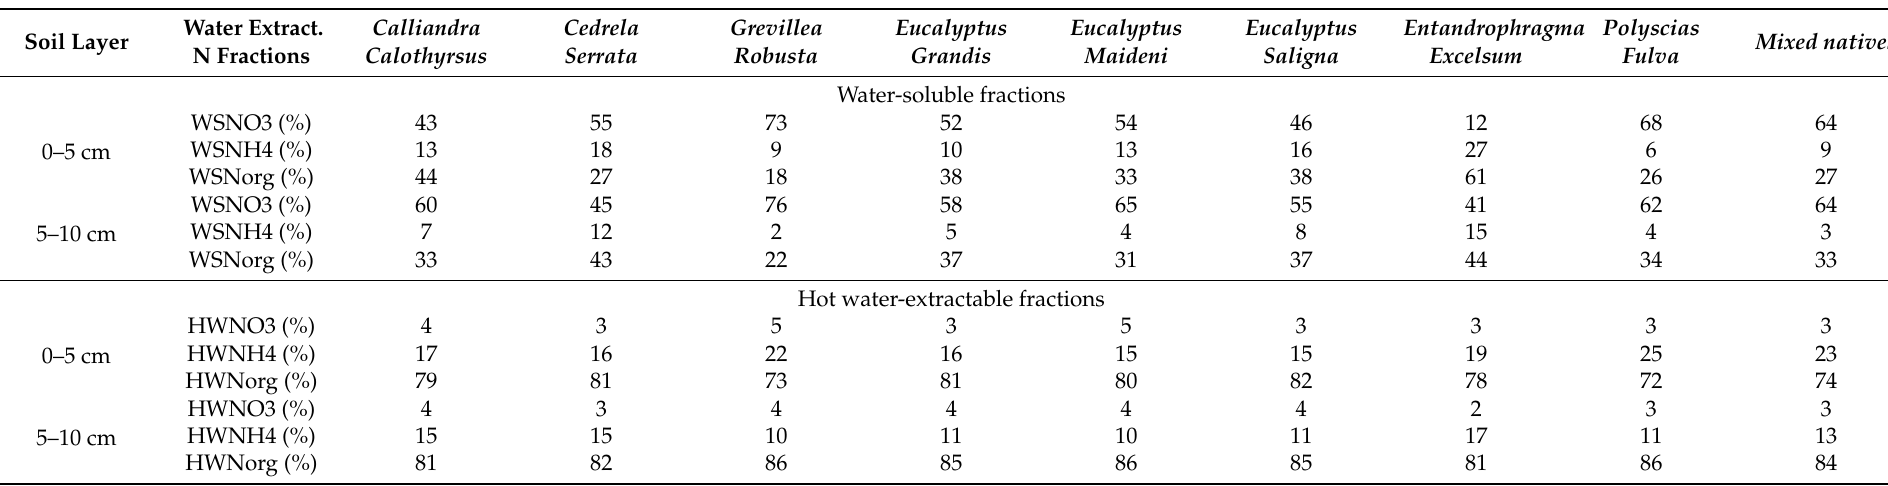
Table A4. Proportions of water-soluble and hot water-extractable nitrogen forms under different tree species at two soil layers (0–5 cm and 5–10 cm) (Rwibasira et al., Long-term effect of forest plantation species on soil chemical properties in Southern